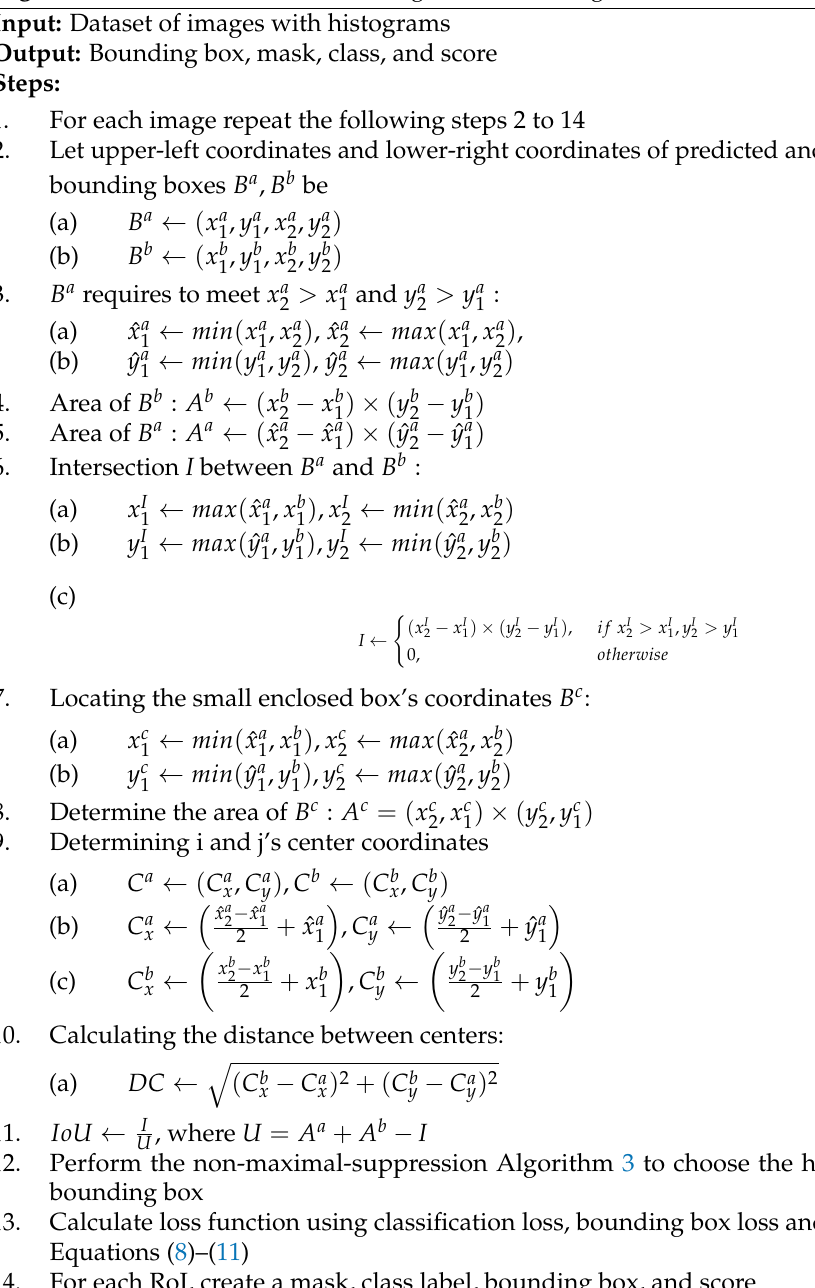
Algorithm 2 Procedure for instance segmentation using